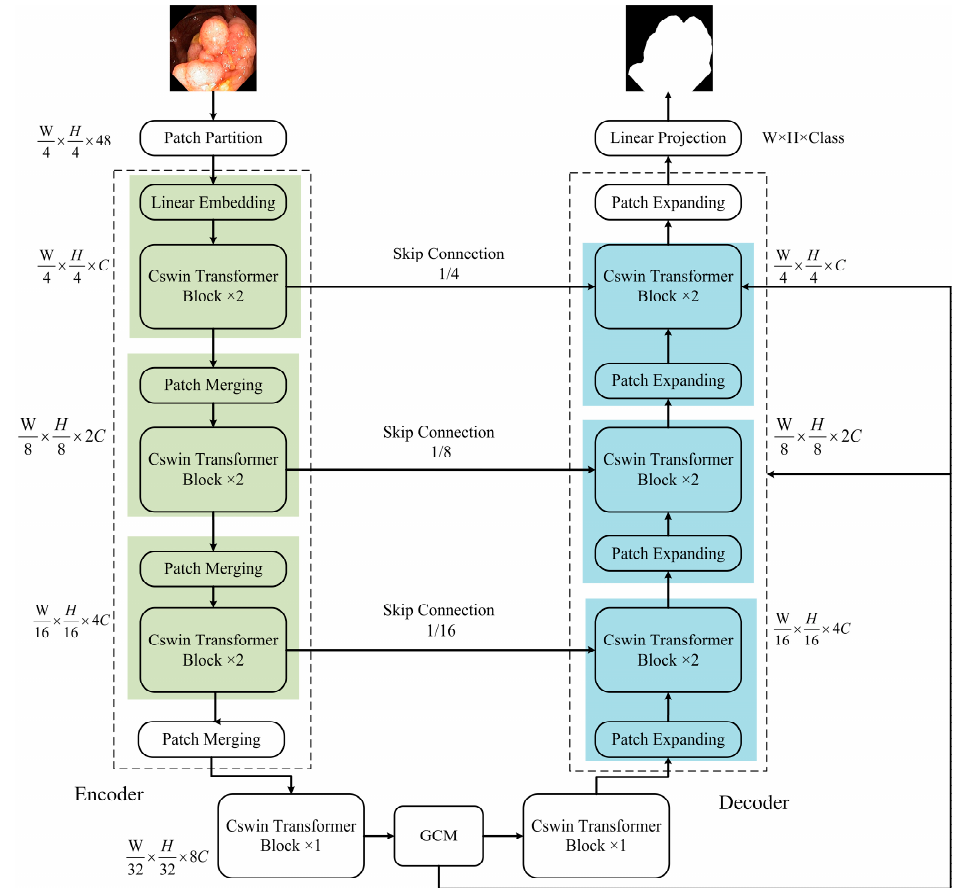
Figure 1. The overall architecture of our GCCSwin-UNet for polyp segmentation.